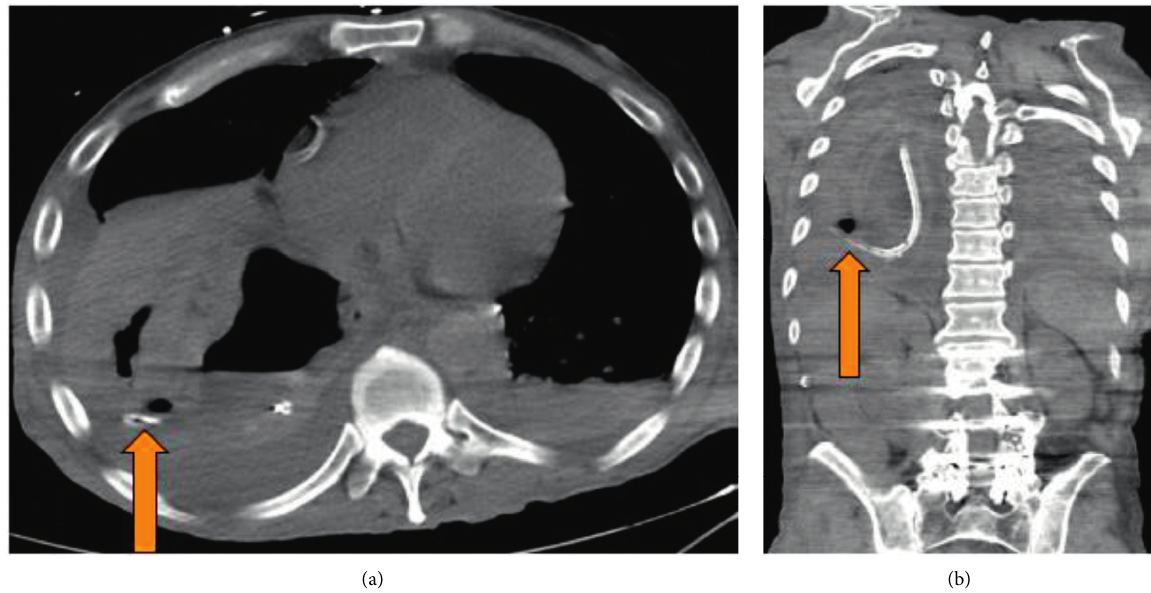
Figure 2: The arrow in (a) and (b) demonstrate a catheter passing from the stomach into the pleural cavity consistent with gastropleural